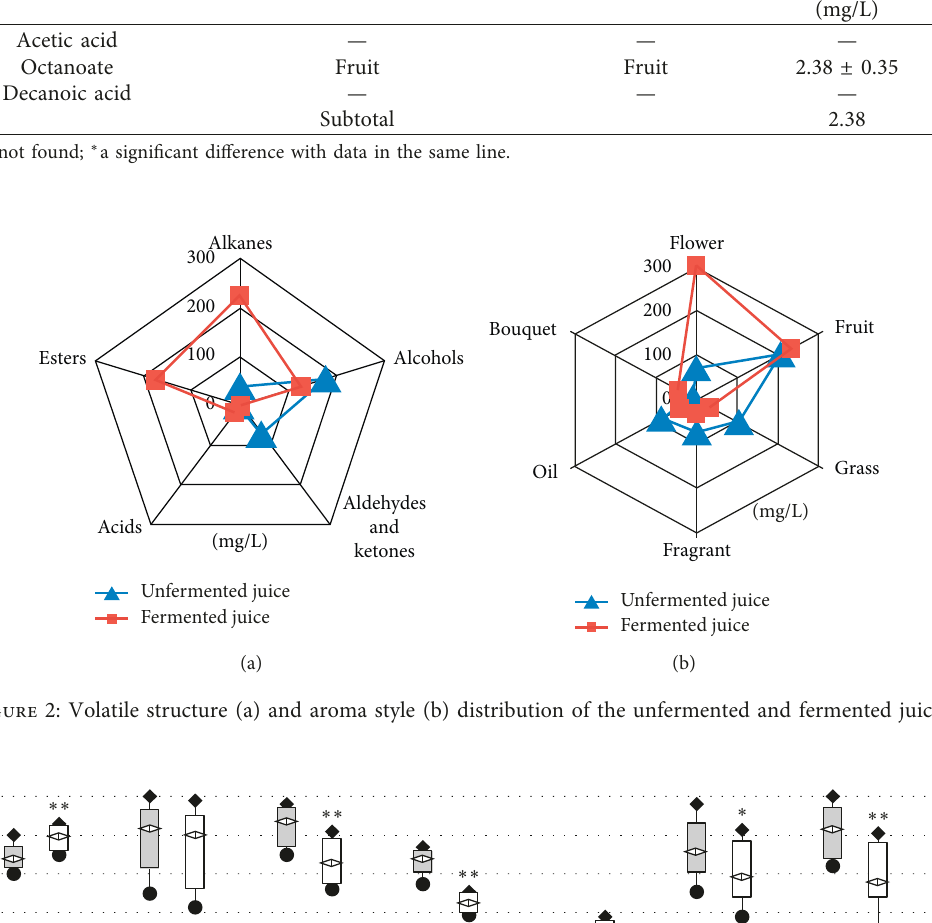
is the maximum of the score; • is the minimum of the score; is the and represent the significant ◆ ∗ ∗∗